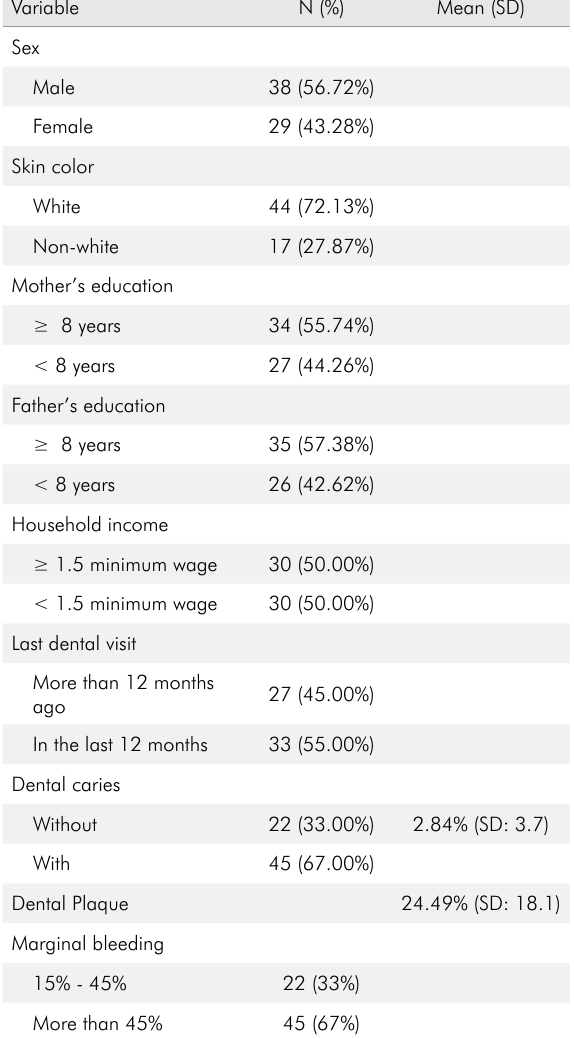
Table 1. Characteristics of the sample.